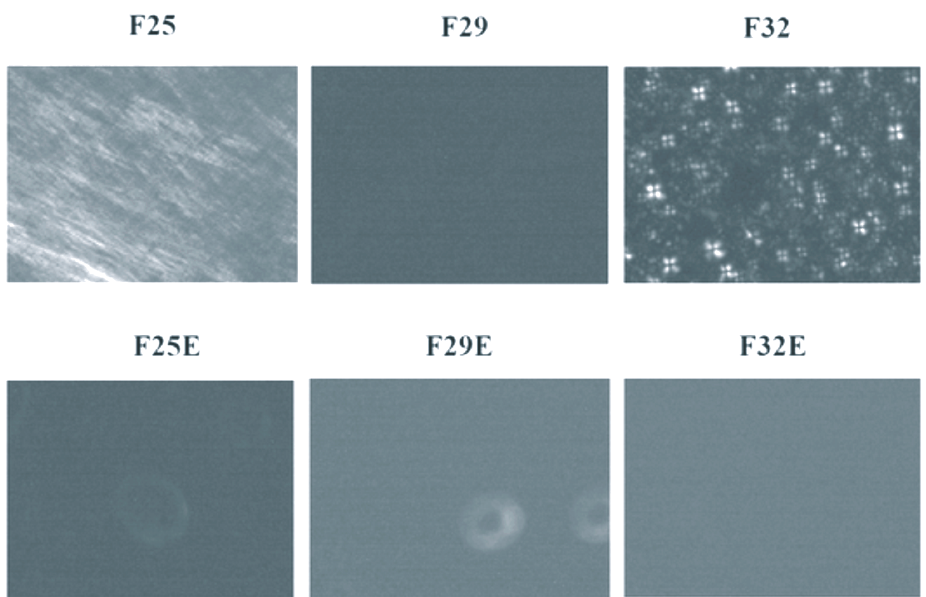
Figure 2. Polarized light microscopy of the selected formulations with and without green tea extract. The formulations F25, F29, and F32 showed hexagonal phase, cubic phase, and lamellar phase, respectively, and all the formulations (F25E, F29E, and F32E) with green tea extract showed cubic phase.